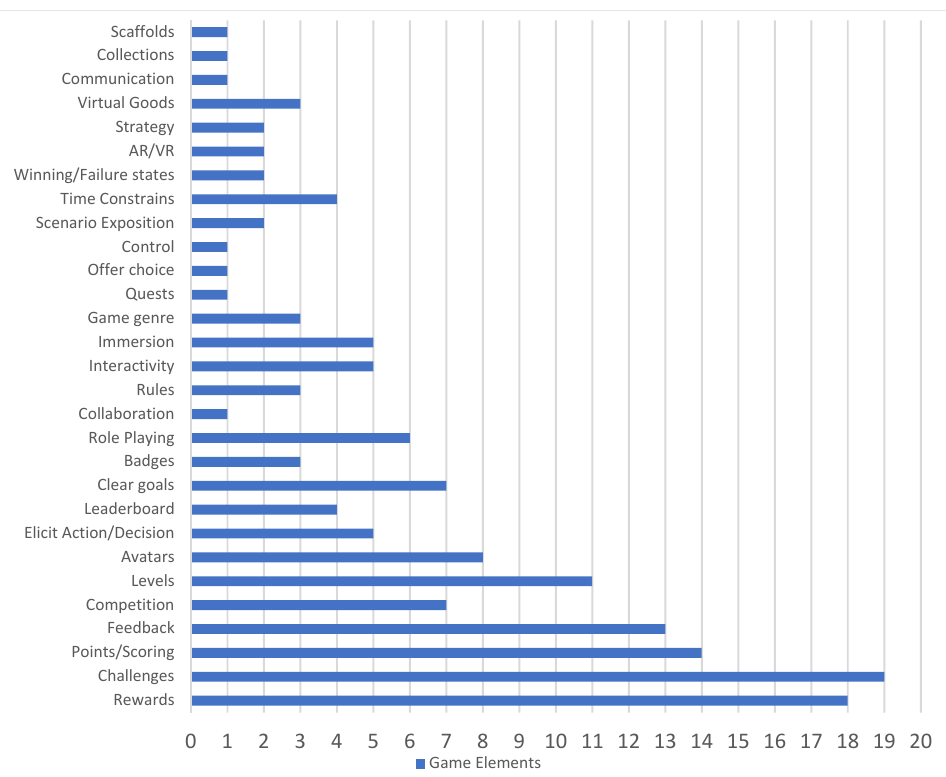
Figure 5 . The frequencies of game features in the Health domain. Figure 5. The frequencies of game features in the Health